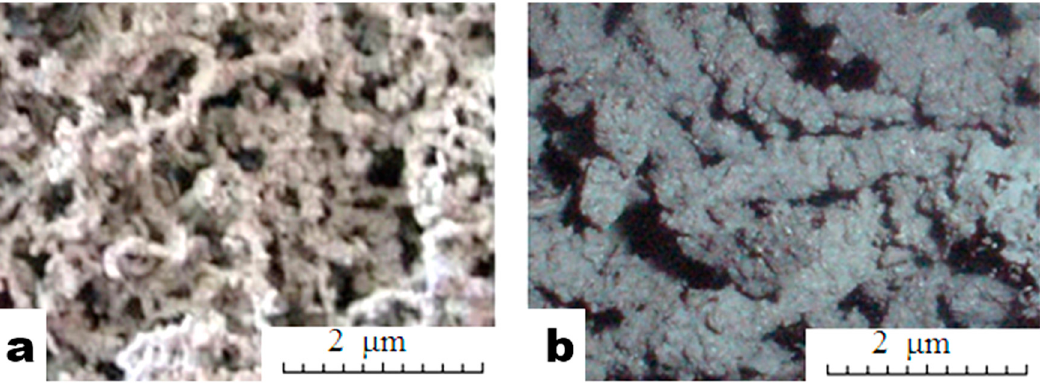
Figure 3. The structure of Ni/MGO catalysts. ( a )—More and ( b )—less than half of the active component.